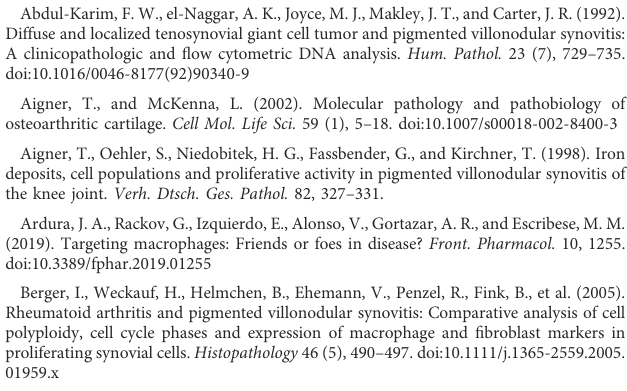
SUPPLEMENTARY FIGURE S1 Normalizeddata boxplot. Different hues denote different samples. Samples are represented by rows, gene expression levels are represented by columns. SUPPLEMENTARY FIGURE S2 Leftpanelshowsnetworkconnectivityhistogram.Therightpaneldepictsalog- log histogram, select soft threshold power of eight and R2 greater than